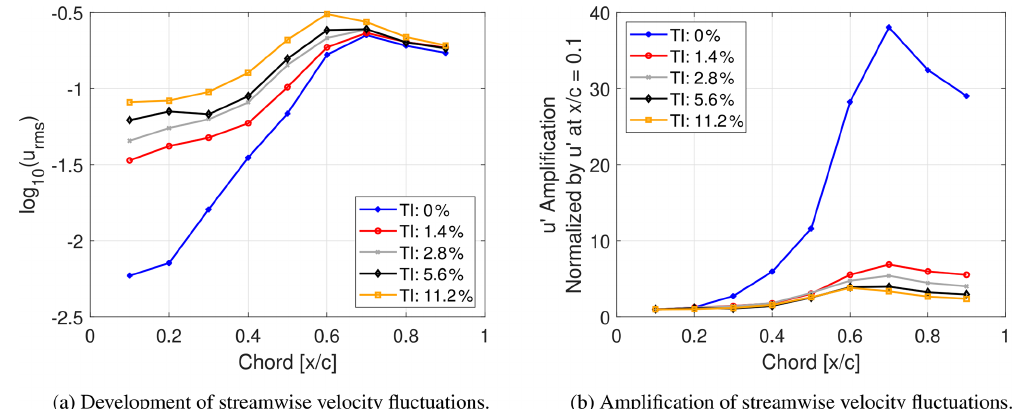
Figure 8. Development and amplification of rms values of the streamwise velocity fluctuations at different inflow turbulence intensities determined at the height of the displacement thickness.